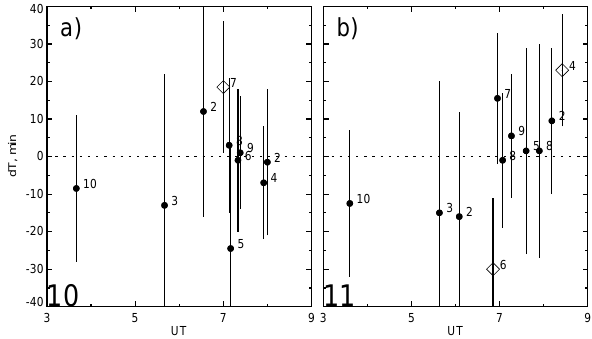
Fig. 5. The time difference between the motion direction rever- sals as determined from two different methods versus the reversal time from the second method: (a) from the absorption images and keograms and (b) from the absorption images and magnetic pertur- bations. The total number of points is indicated in the bottom left corner of each panel. The diamonds mark the points that are farther from the zero time difference than the estimate uncertainty (verti- cal bars). The digits by each point indicate the event number from Table 1.